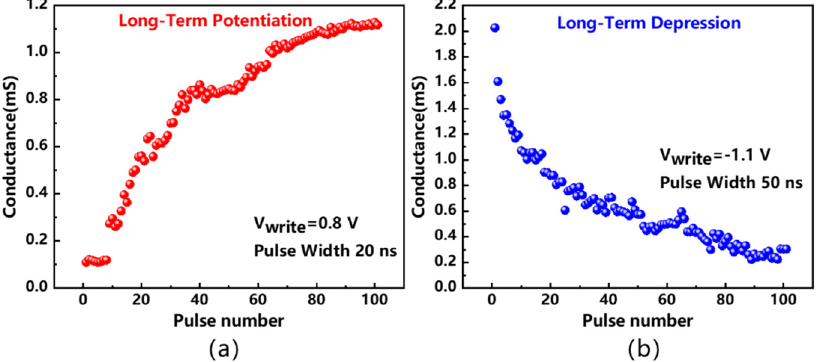
Figure 7. Long-term potentiation (LTP) and depression (LTD) of Pt/TaO x :Al/TiN RRAM with 100 optimized identical ( a ) positive pulses (0.8 V, 20 ns) and ( b ) negative pulses ( − 1.1 V, 50 ns).